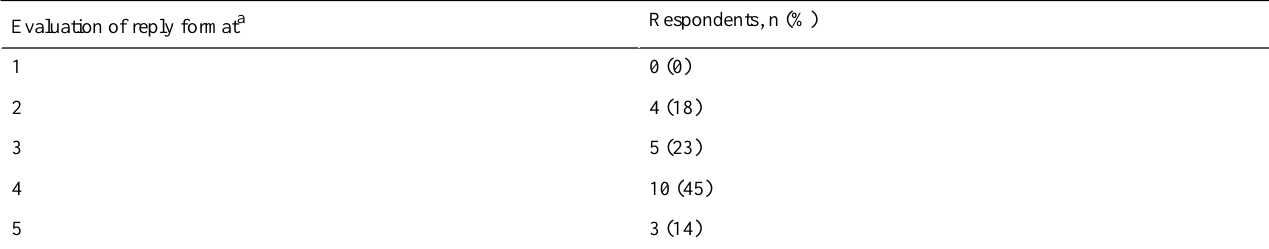
Table 2. Participants’views on the format of reply to the virtual